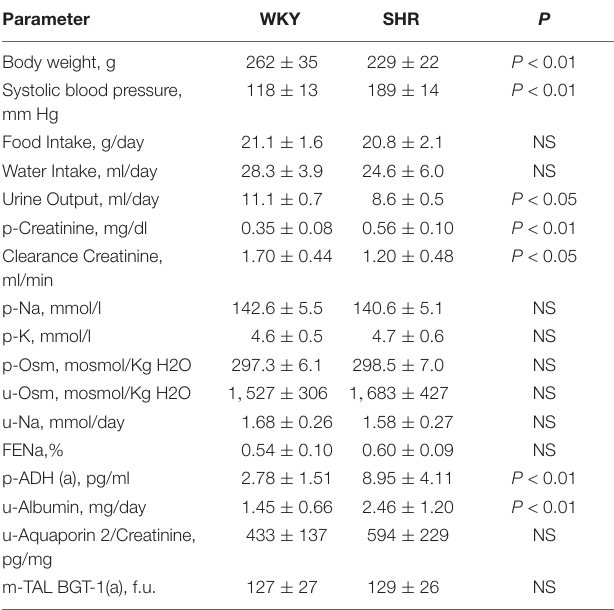
TABLE 2 | Baseline parameters of the studied groups of female (195–211 days–28–30-week-old) WKY, n = 15 and SHR, n = 30. Parameter